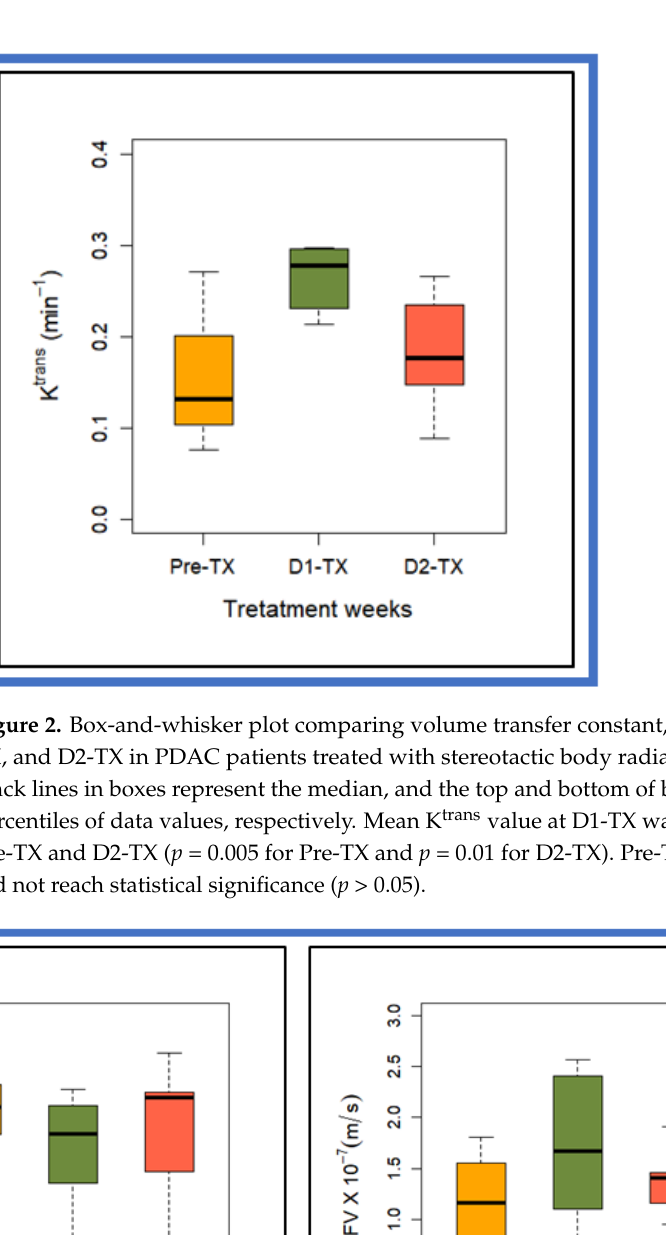
Table 1. K trans , IFP, and IFV values at three-time points.